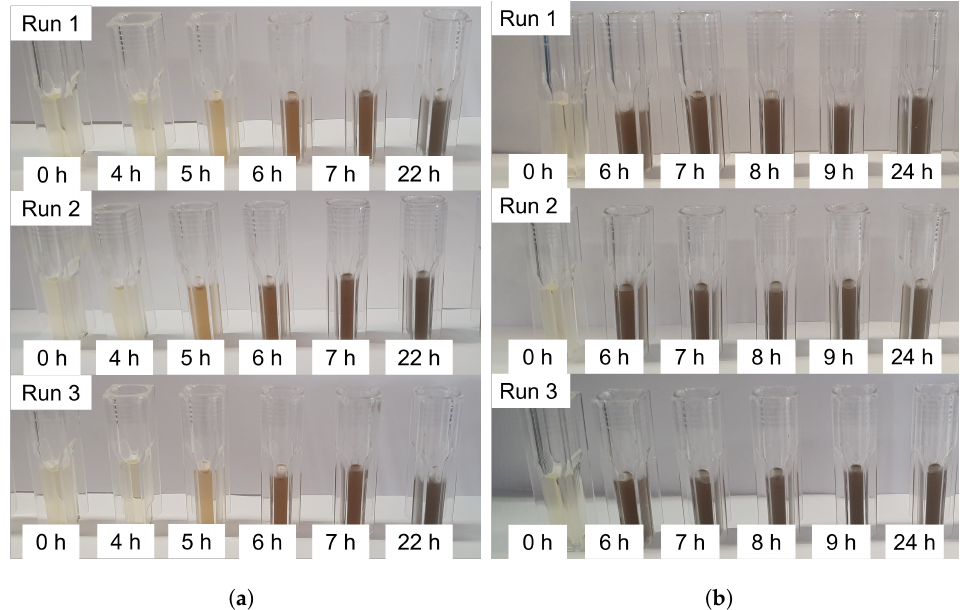
Figure 4. The visual results of the three duplicates for both experiments containing 80 mg/L initial Pb(II) concentration. ( a ) The visual results for the experiment involving K. pneumoniae . ( b ) The visual results for the experiment involving P. bifermentans